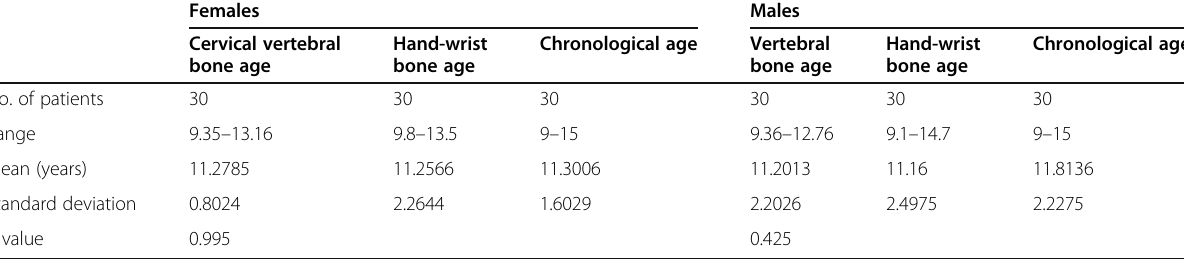
Table 2 One-way ANOVA test comparing the calculated cervical vertebral bone age, hand-wrist bone age, and chronological age